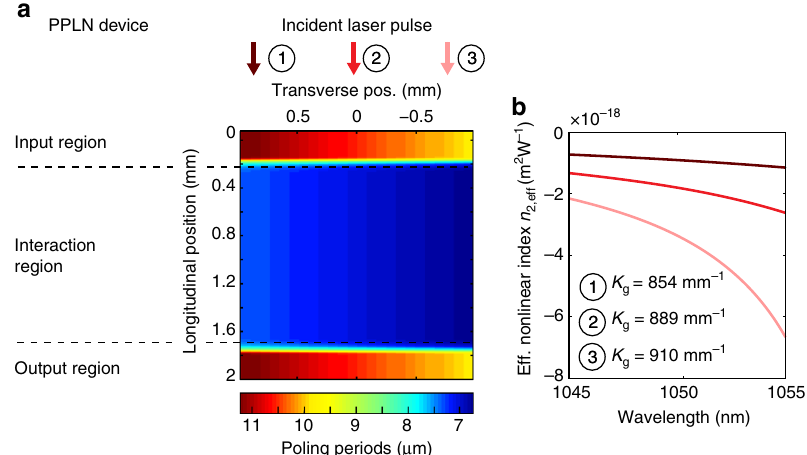
Fig. 2 PPLN device. a Illustration showing a two-dimensional variation of the quasi-phase matching (QPM) domain structure. The grating vector K g is varied smoothly along the x -direction to enable tuning of the nominal phase-mismatch and hence the effective nonlinear index n 2,eff . The variation in K g along the beam propagation direction has been designed in order to adiabatically turn the SHG interaction on/off: in the input region, the phase mismatch is adiabatically decreased to reach the value desired to obtain strong self-phase modulation (interaction region) and is then increased again in the output region to minimize the nonlinear losses. b Calculated effective nonlinear index in the device as a function of wavelength for three different values of the phase mismatch, corresponding to the transverse positions (1) – (3) with respect to the incoming beam. The calculations are based on material data for MgO-doped lithium niobate reported by Gayer et al.